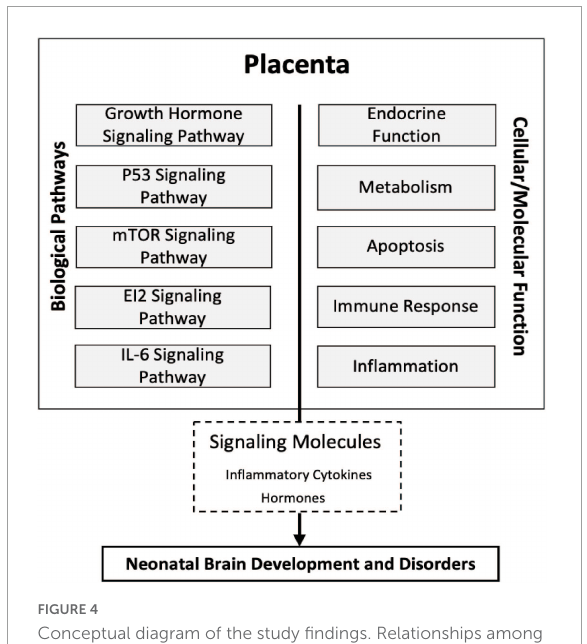
FIGURE4 Conceptual diagram of the study findings. Relationships among molecular processes associated with cerebral white matter damage that may provide insight into the physiologic state of the placentas, transcriptomic pathways, and neonatal brain development. Five novel signaling pathways eukaryotic translation initiation factor 2 (eIF2), interleukin-6 (IL-6), and mammalian target of rapamycin (mTOR), growth hormone, and tumor protein P53 (p53) in relation to ventriculomegaly associated cerebral white matter brain damage relatively early in life. Many of the cellular/molecular processes are associated with more than one signaling pathway and there may be shared overlap of many of the genes within a given